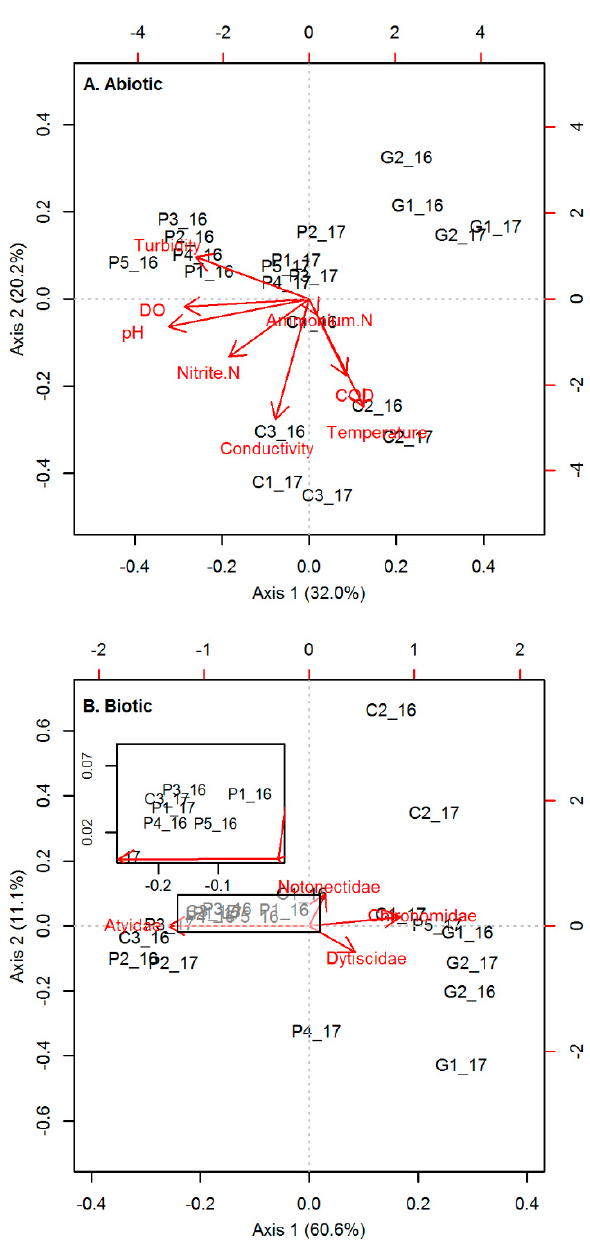
Figure 2. Principal component analysis (PCA) of freshwater sites at San Cristóbal island (Galapagos). ( A ) Abiotic-based ordination; ( B ) (simplified) biotic-based ordination. The inset shows a detailed close-up of the area along the primary axis (indicated by a transparent rectangle). The data represent 10 sites within three separate basins (P, C, and G) from two consecutive years (2016 and 2017).